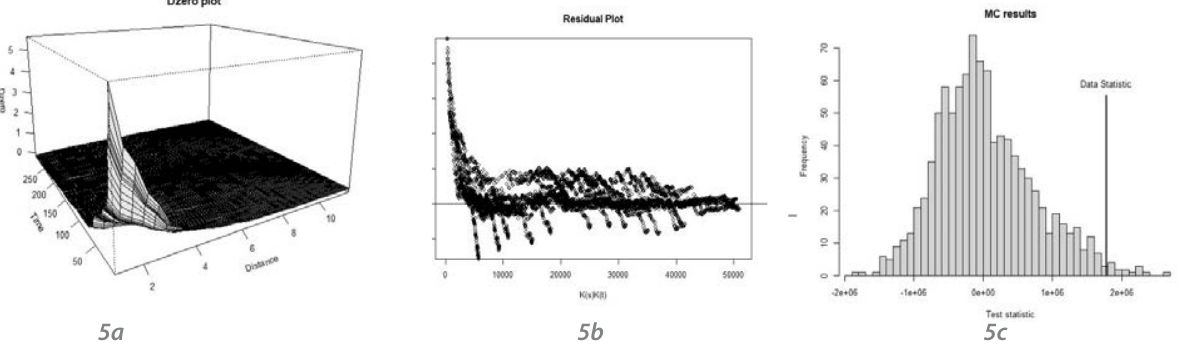
Figure 5: Diagnostic plots for space-time clustering at month scale (a: the perspective plot of the difference between spatiotemporal K-function and the product of the spatial and temporal K-functions; b: the standardised residuals against the product of the spatial and temporal K-functions (middle) and c: histogram of the test statistics, where the statistic for the data is indicated with a vertical line)